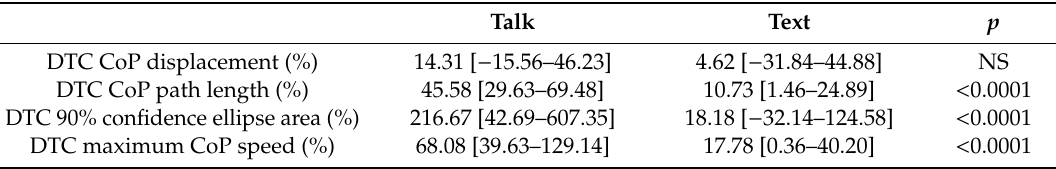
Table 4. Proportional DTC for stabilometric parameters in talk and text